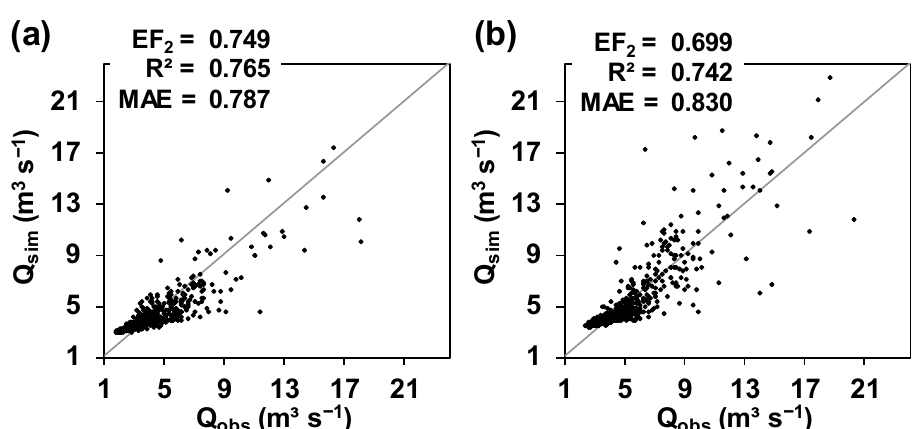
Figure 4. Scatter plots of total streamflow observed (Q obs ) and predicted (Q sim ) by SHETRAN, at the outlet of the catchment, for ( a ) the calibration period [1 of January 1985–31 of December 1986]; and ( b ) the validation period [1 of January 1987–31 of December 1988]. EF 2 = Coefficient of Efficiency (Nash and Sutcliffe Efficiency); R 2 = square of the Pearson’s type (linear) correlation coefficient; MAE = Mean Absolute Error.